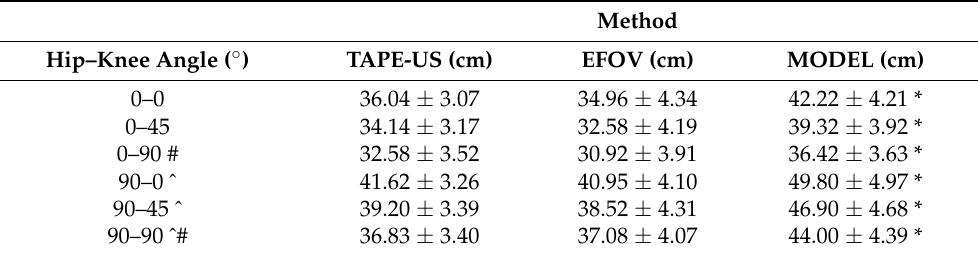
Table 2. Mean ( ± SD) group values of the BFlh length (cm) at six combinations of hip and knee flexion angles, assessed using three different methods (* statistically significant different compared with TAPE-US and EFOV-US method, ˆ values collapsed across methods and knee joint positions significantly different compared with a 0 ◦ hip flexion angle, # values collapsed across methods, and hip joint angles significantly different compared with a 0 ◦ knee flexion angle, p < 0.05).